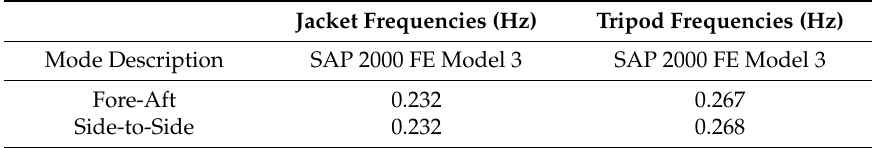
Table 2. Natural frequencies of two-degree-of-freedom FE Model